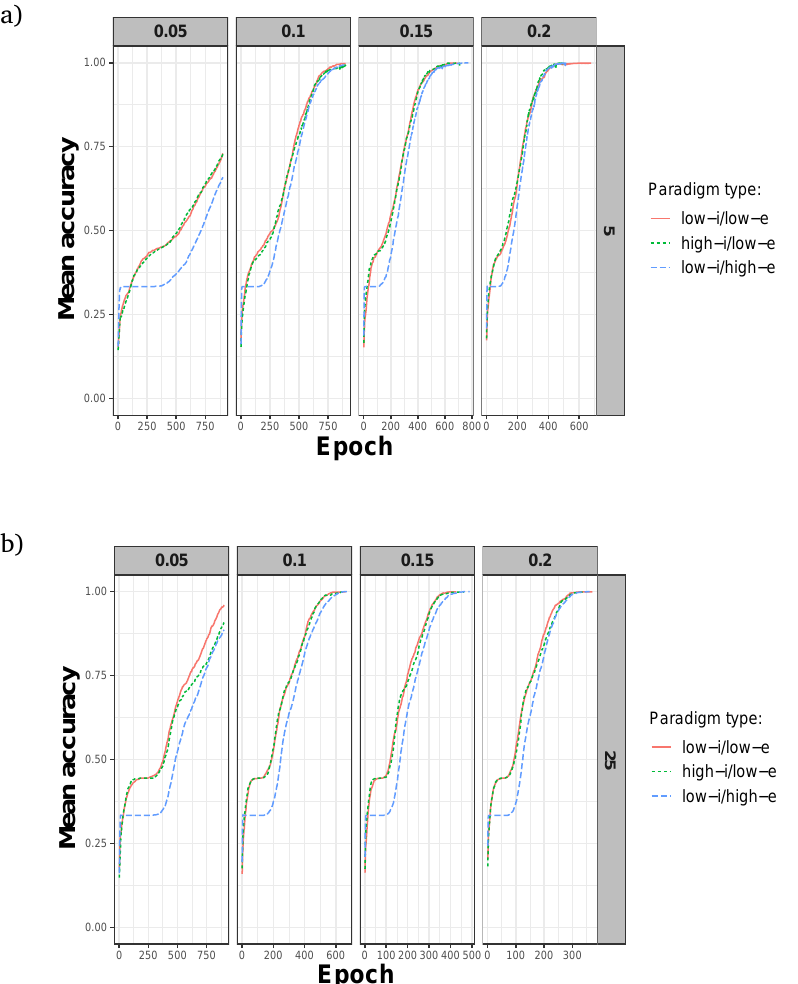
Figure 10: Learning trajectories of networks with two embedding and hidden layer dimensionalities; (a) networks with 5-dimensional embedding vectors and hidden layer, (b) networks with 25-dimentional embedding vectors and hidden layer, trained with different learning rates (columns), and optimized with SGD. X axis shows number of epochs up to perfect learning of the forms in the language (differs across learning rates and network